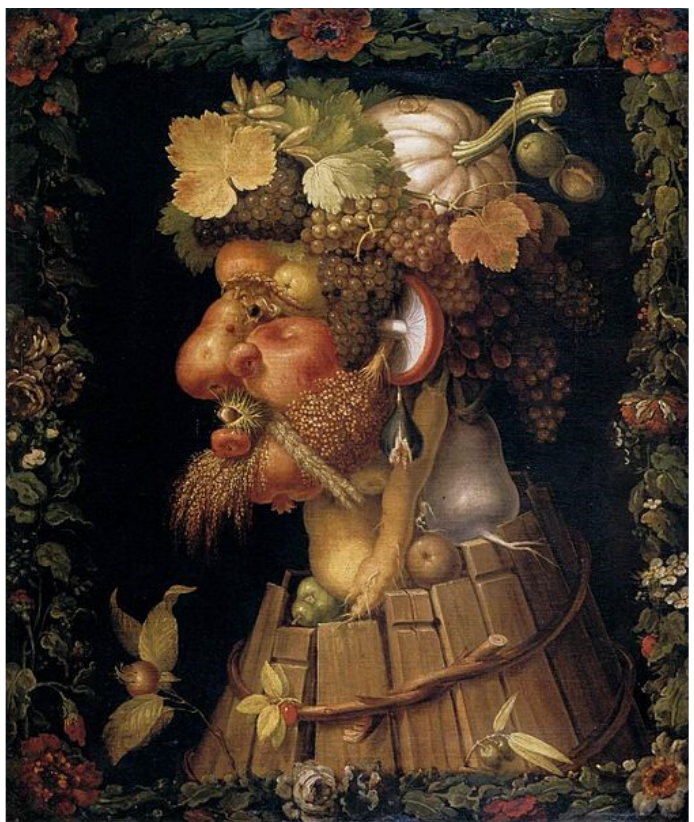
Figure 4. Arcimboldo, Giuseppe. 1573. Automne. https://upload.wikimedia.org/wikipedia/commons/9/90/Giuseppe_Arcimboldo_-_Autumn_-_WGA00812.jpg (accessed on 18 July 2022).